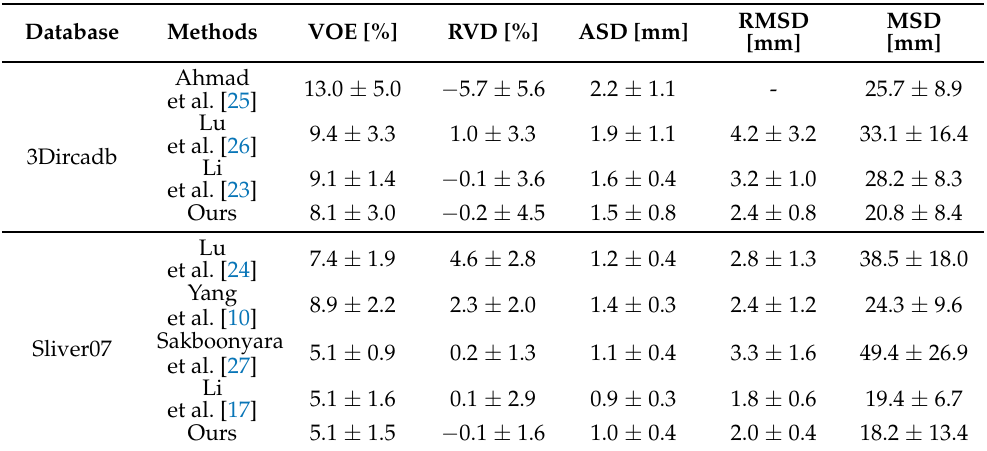
Table 2. Segmentation performance comparison of different methods (A ± B = mean value ± standard